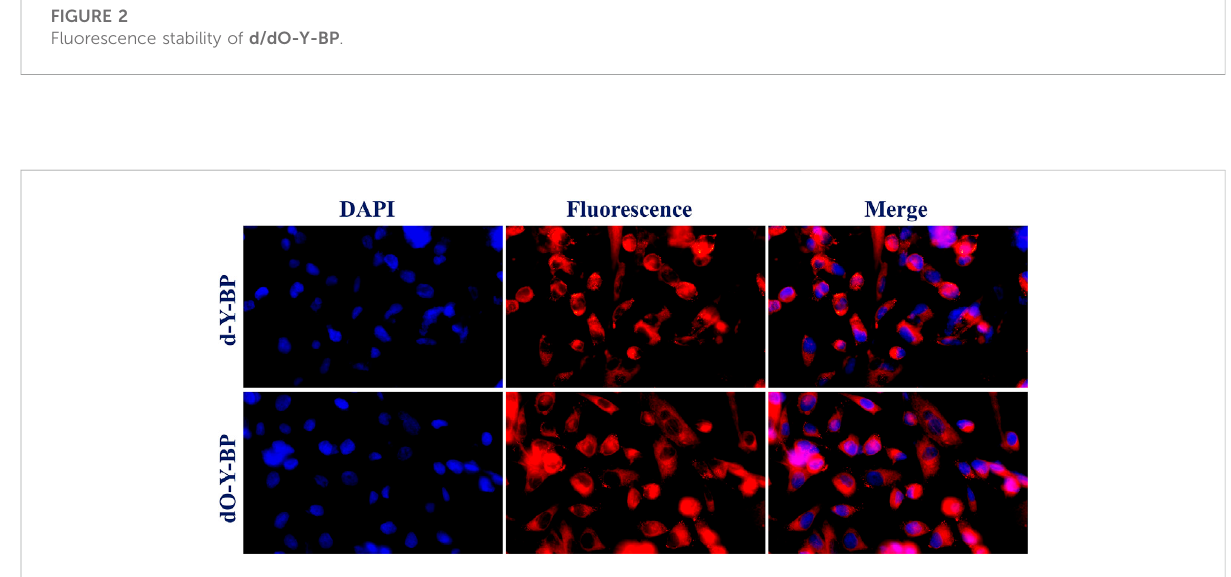
FIGURE 3 Cell imaging of treated HeLa cells with d/dO-Y-BP for 48